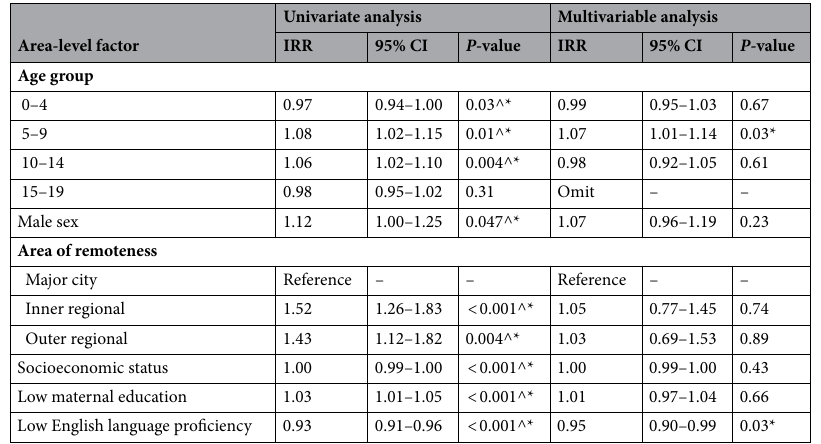
Table 2. Area-level factors influencing likelihood of adenotonsillectomy. ^Denotes p -value < 0.1 for univariate analysis for further inclusion into the multivariable model. *Denotes significance at p -value < 0.05. IRR incidence rate